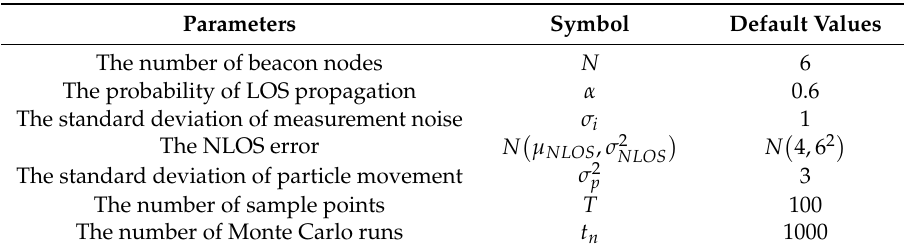
Table 2. The default parameter